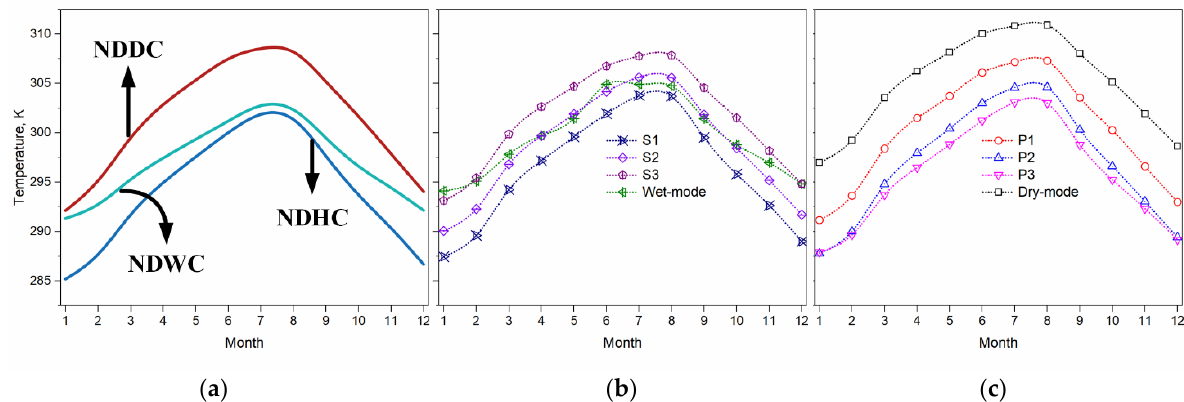
Figure 3. Water temperature at the outlet of different cooling systems: ( a ) NDDC, NDWC and NDHC, ( b ) serial mode of NDHC, ( c ) parallel mode of NDHC.